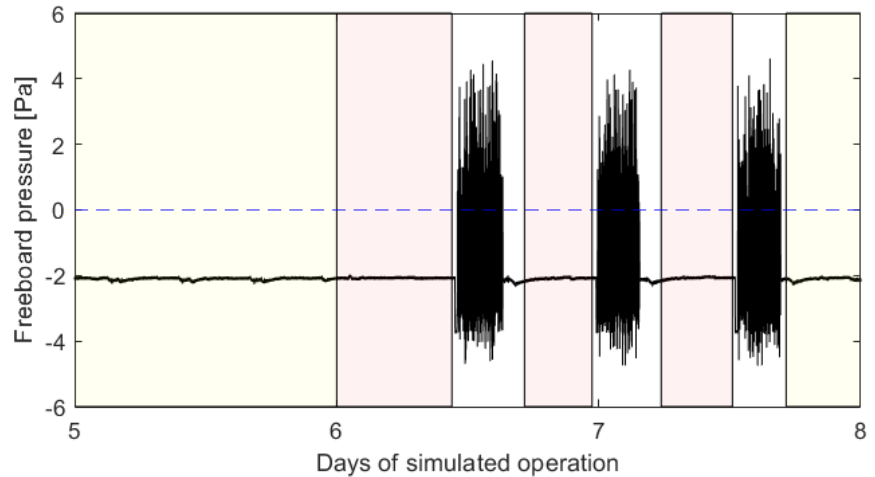
Figure 7. Illustration of the ground truth of the simulated data w.r.t. the presence of blowback- causing faults. Fault-free observations are found in the area shaded in gold. Faulty observations are found in the area shaded red. Unshaded areas contain blowback-causing faults but sounding the alarm here would either be redundant due to blowbacks already occurring or would not provide sufficient warning before the blowback. The dashed blue line indicates zero gauge pressure.